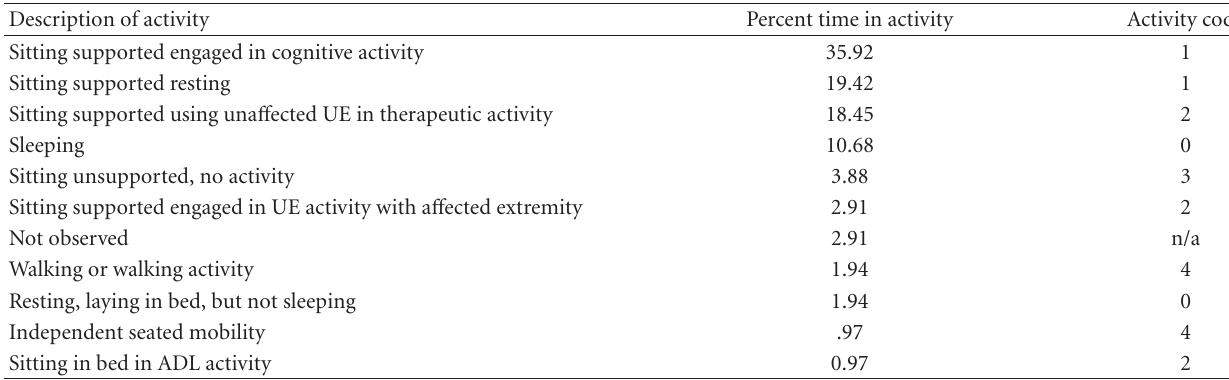
Table 1: Percent time in physical activity during rehabilitation day a